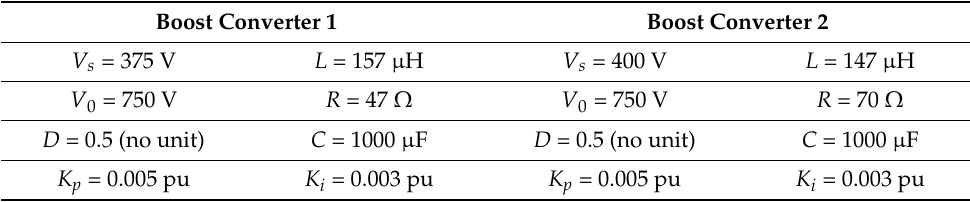
Table 3. Parameters of the DC–DC boost converters.